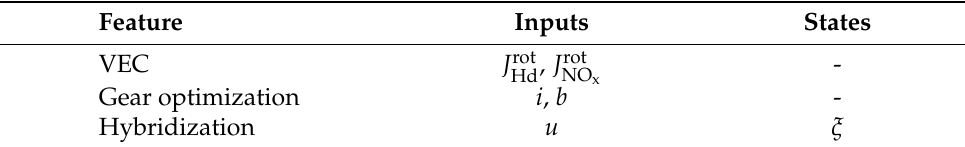
Table 2. Additional states and inputs for each powertrain feature.